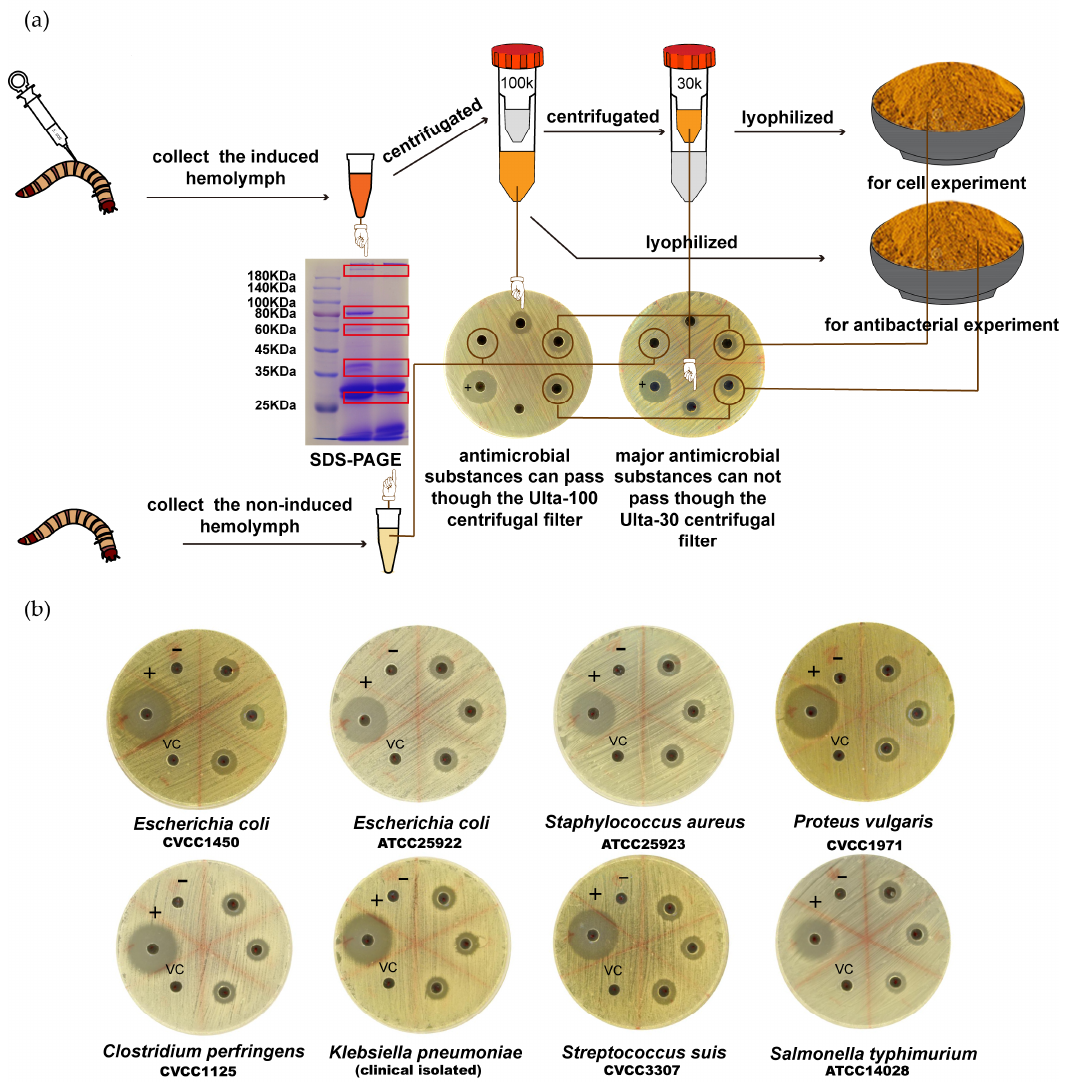
Figure 1. Preparation of antimicrobial hemolymph of Z. morio and the results of plate-based inhibition zone assay. ( a ) Workflow illustration of Z. morio hemolymph production. The red boxes represent bands that differ between the induced group and the noninduced group in the SDS-PAGE assay. ( b ) Susceptibility detection of bacteria to Z. morio hemolymph by disc agar diffusion method. The plus sign (+) indicates positive control (gentamicin 10 U/well); the minus sign indicates negative control. VC indicates vehicle control (saline solution 20 μL/well).